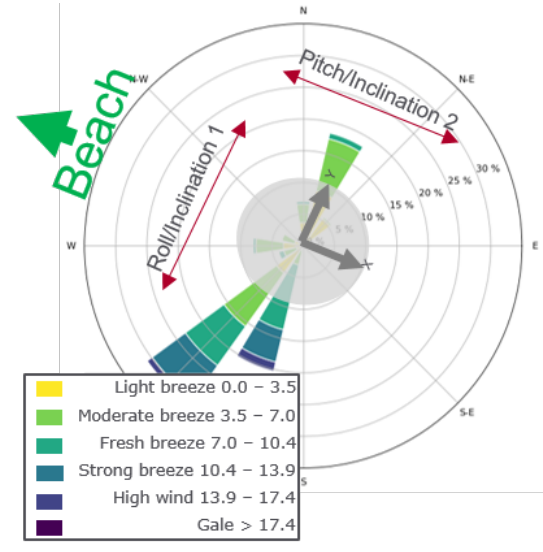
Figure 3. The relative location of the inclination sensors with respect to the laser scanner (at the center) and the beach (to the North-West) is indicated. In addition the main prevailing wind direction during the observation period is shown.